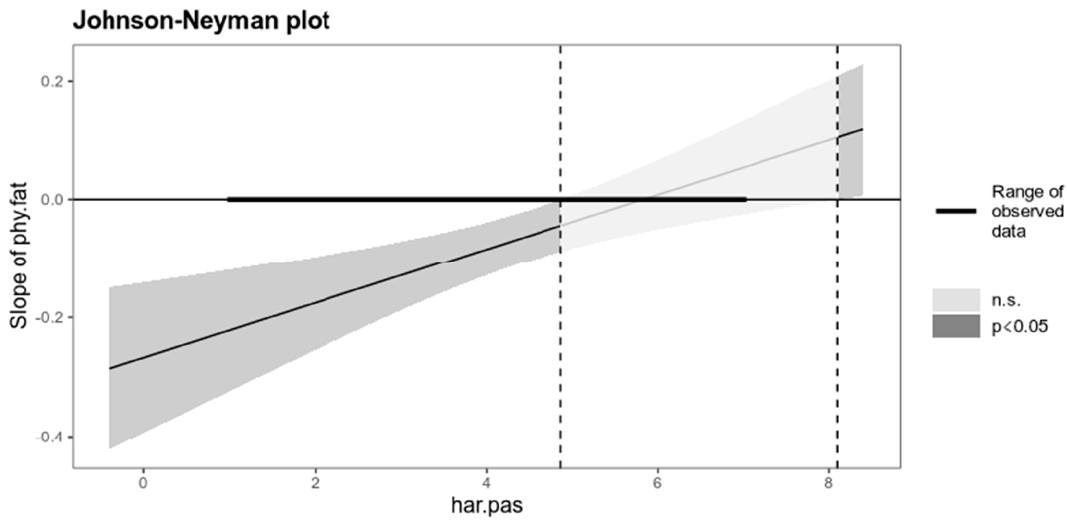
Figure 2. Johnson-Neyman graph for the interaction